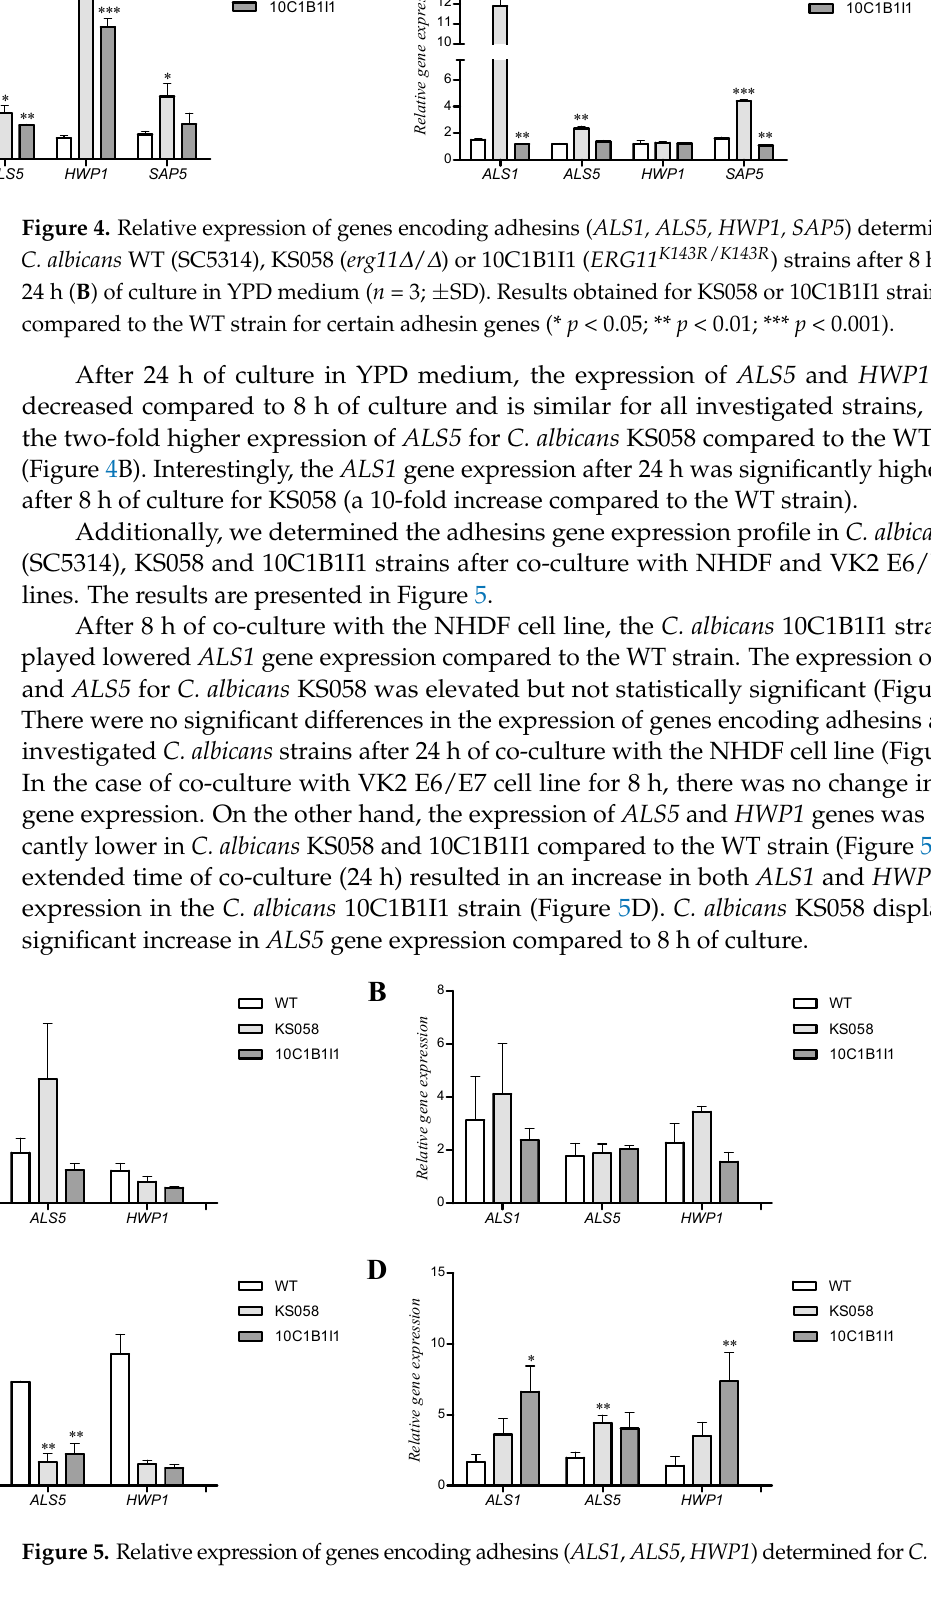
Figure 5. Relative expression of genes encoding adhesins ( ALS1 , ALS5 , HWP1 ) determined for C. albicans WT (SC5314), KS058 ( erg11 Δ / Δ ) or 10C1B1I1 ( ERG11 K143R / K143R ) strains for NHDF after 8 ( A ) or 24 h ( B ) and for VK2 E6/E7 cell lines after 8 ( C ) or 24 h ( D ) of co-culture ( n = 3; ±SD). Results obtained for KS058 or 10C1B1I1 strains were compared to the WT strain for certain cytokine genes (*, p < 0.05; **, p < 0.01).